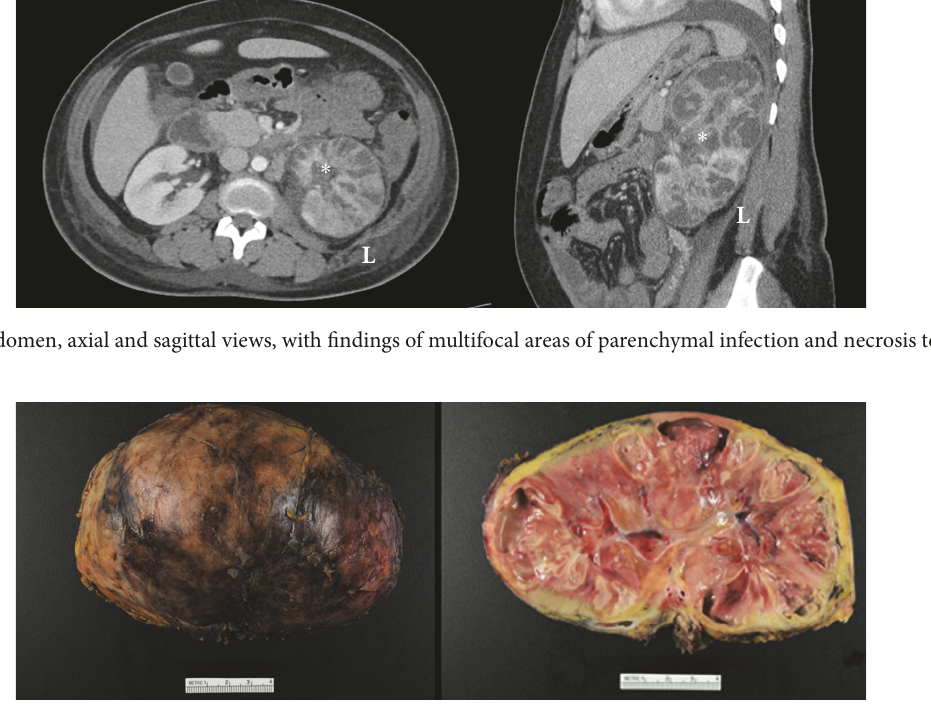
Figure 2: Renal parenchyma shows severe acute pyelonephritis with multifocal abscess formation and multifocal renal